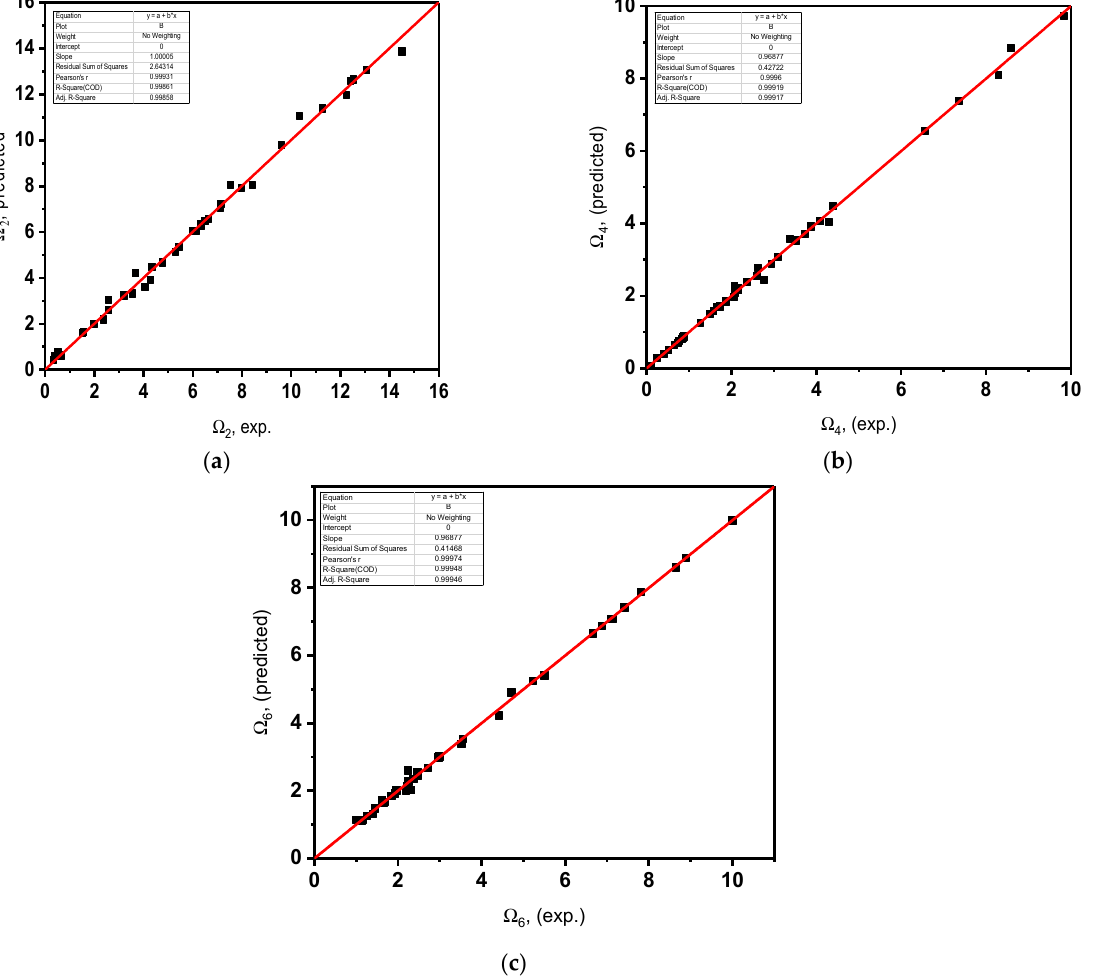
Figure 6. Experimentally estimated Judd–Ofelt parameters against predicted utilizing ANN. ( a ) Estimated Judd–Ofelt parameter Ω against predicted Ω 2 utilizing ANN. ( b ) Estimated Judd–Ofelt parameter Ω 4 against predicted Ω 4 utilizing ANN. ( c ) Estimated Judd–Ofelt parameter Ω 6 against predicted Ω 6 utilizing ANN.